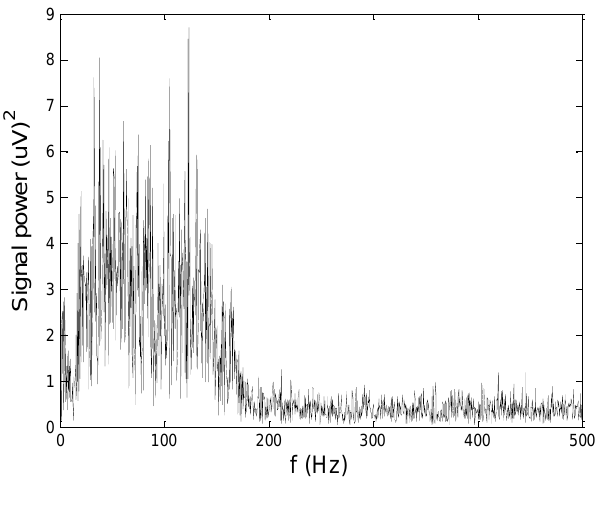
Figure 10. Power spectrum of simulated artificial EMG signal with added